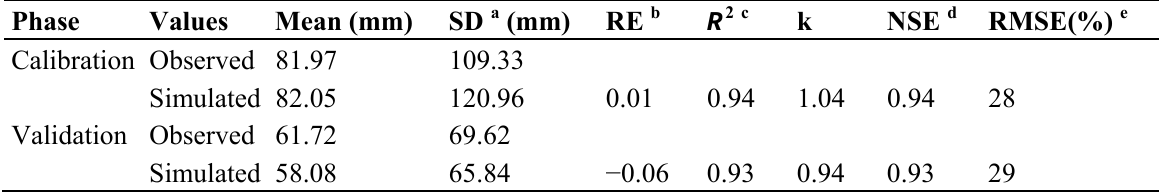
Table 1. Statistics concerning the AnnAGNPS simulations of monthly runoff at Wuxi hydrological station during calibration and validation period.